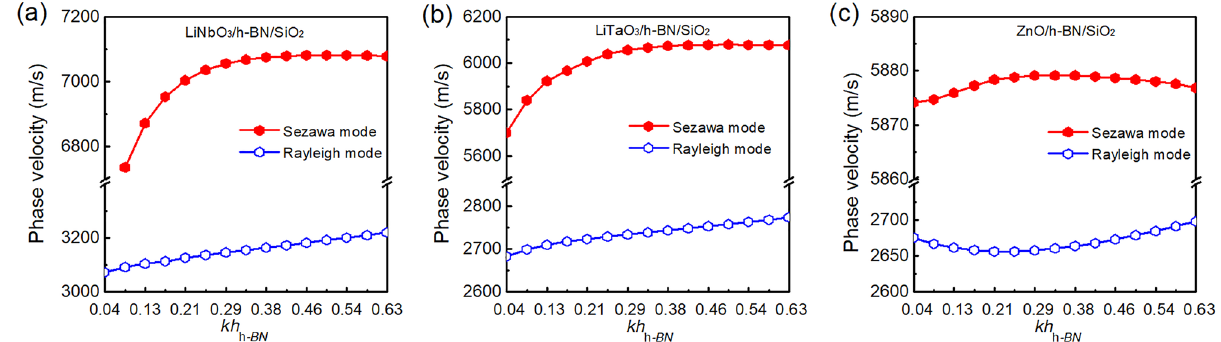
Figure 5. Characteristics of phase velocities depending on the h h-BN with kh h-BN dispersion curves (the λ is fixed at 150 nm). Phase velocities vs. h-BN thickness for Rayleigh and Sezawa modes of ( a ) LiNbO 3 /h-BN/SiO 2 , ( b ) LiTaO 3 /h-BN/SiO 2 , and ( c ) ZnO/h-BN/SiO 2 multilayered